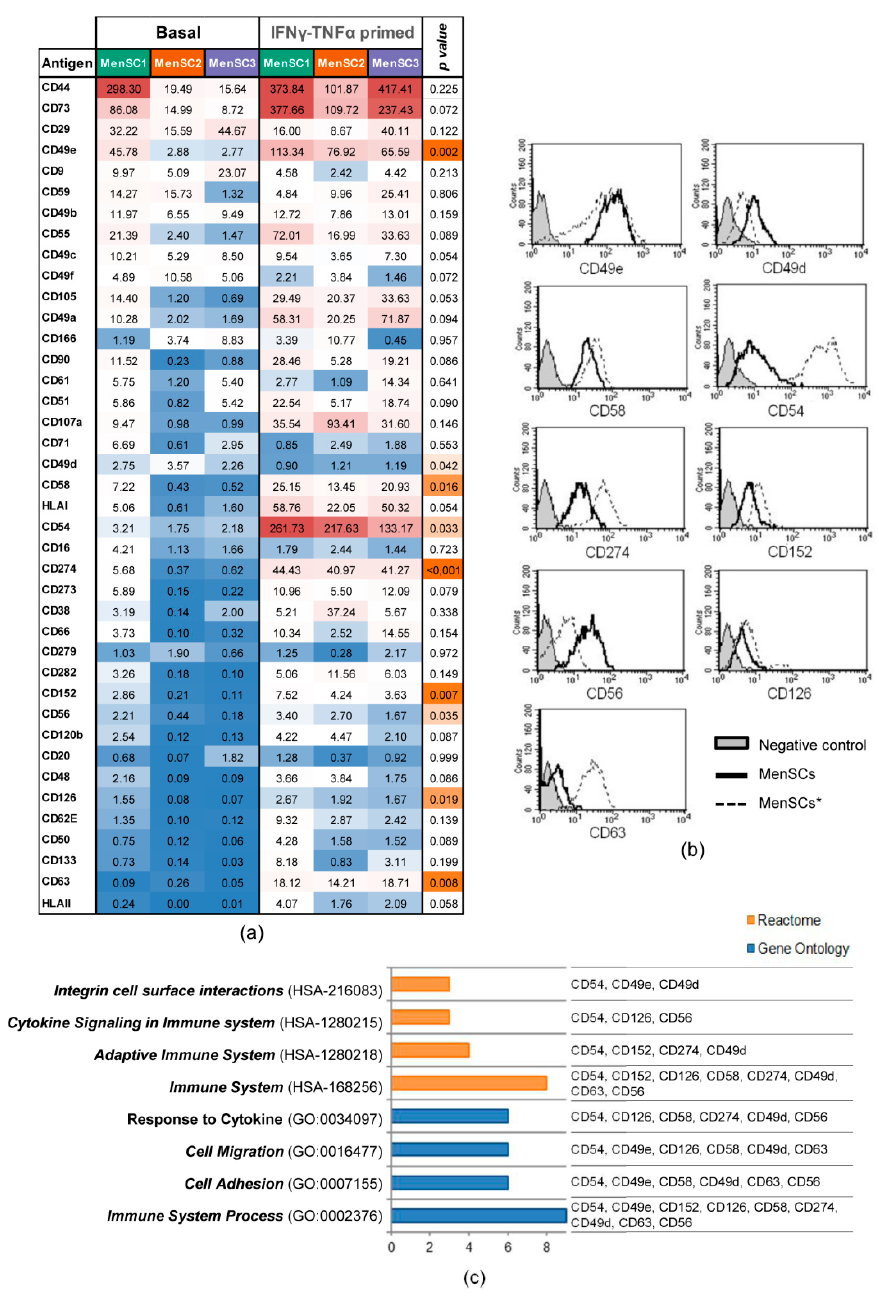
Figure 2. Phenotypic surface marker expression on MenSCs. Analysis of surface markers in basal MenSCs ( n = 3) and MenSCs* ( n = 3) over 3 days. ( a ) The expression levels of 40 cell surface markers (Stain Index (SI) value) are illustrated on a heat map. A paired t -test was carried out to compare MenSCs and MenSCs*, where p < 0.05 was considered statistically significant. The color scale for the SI values illustrates the highest (red) and the lowest (blue) expression values, and the orange color scale indicates the grade of signification, with the most significant ones in dark orange. ( b ) Representative histograms of statistically different markers. The expression in MenSCs is represented by a black-lined histogram, and the expression of MenSCs* is represented by a discontinuous line. The opaque gray histogram corresponds to the fluorescence negative control. ( c ) Reactome and Gene Ontology enrichment analyses of statistically significant different markers were performed by adjusting the p value with Benjamini–Hochberg FDR correction < 0.01. Graph bars represent the number of surface markers annotated into Reactome (orange) and Gene Ontology (blue) categories.